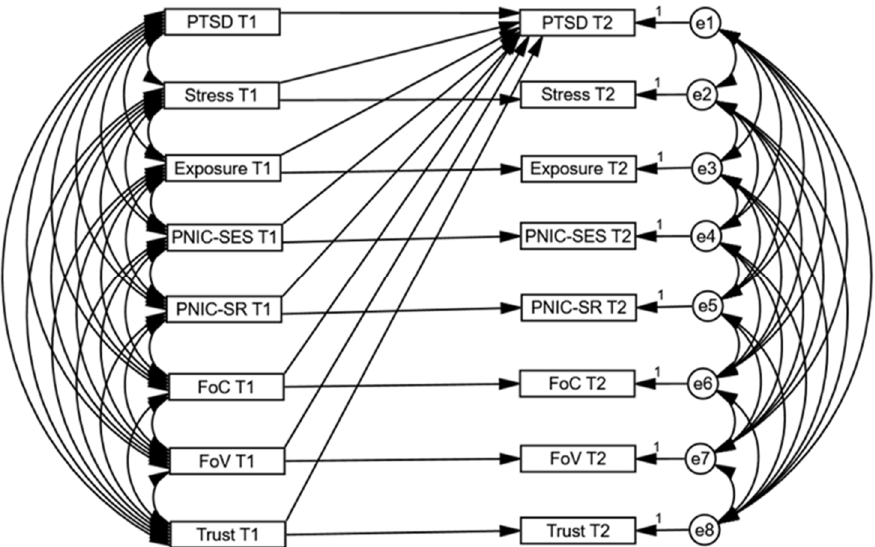
Figure 2. Conceptual model of associations between the variables at T1 and T2 in the lagged regression model ( N = 1723).